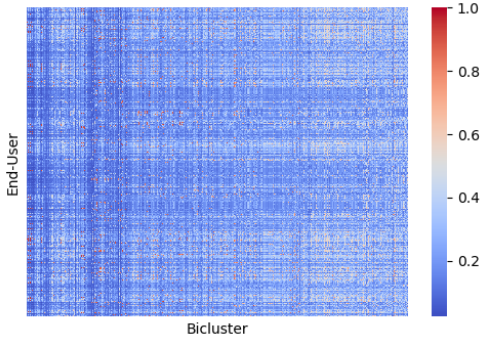
Figure 29. Tabular data obtained by comparing end-users with discovered